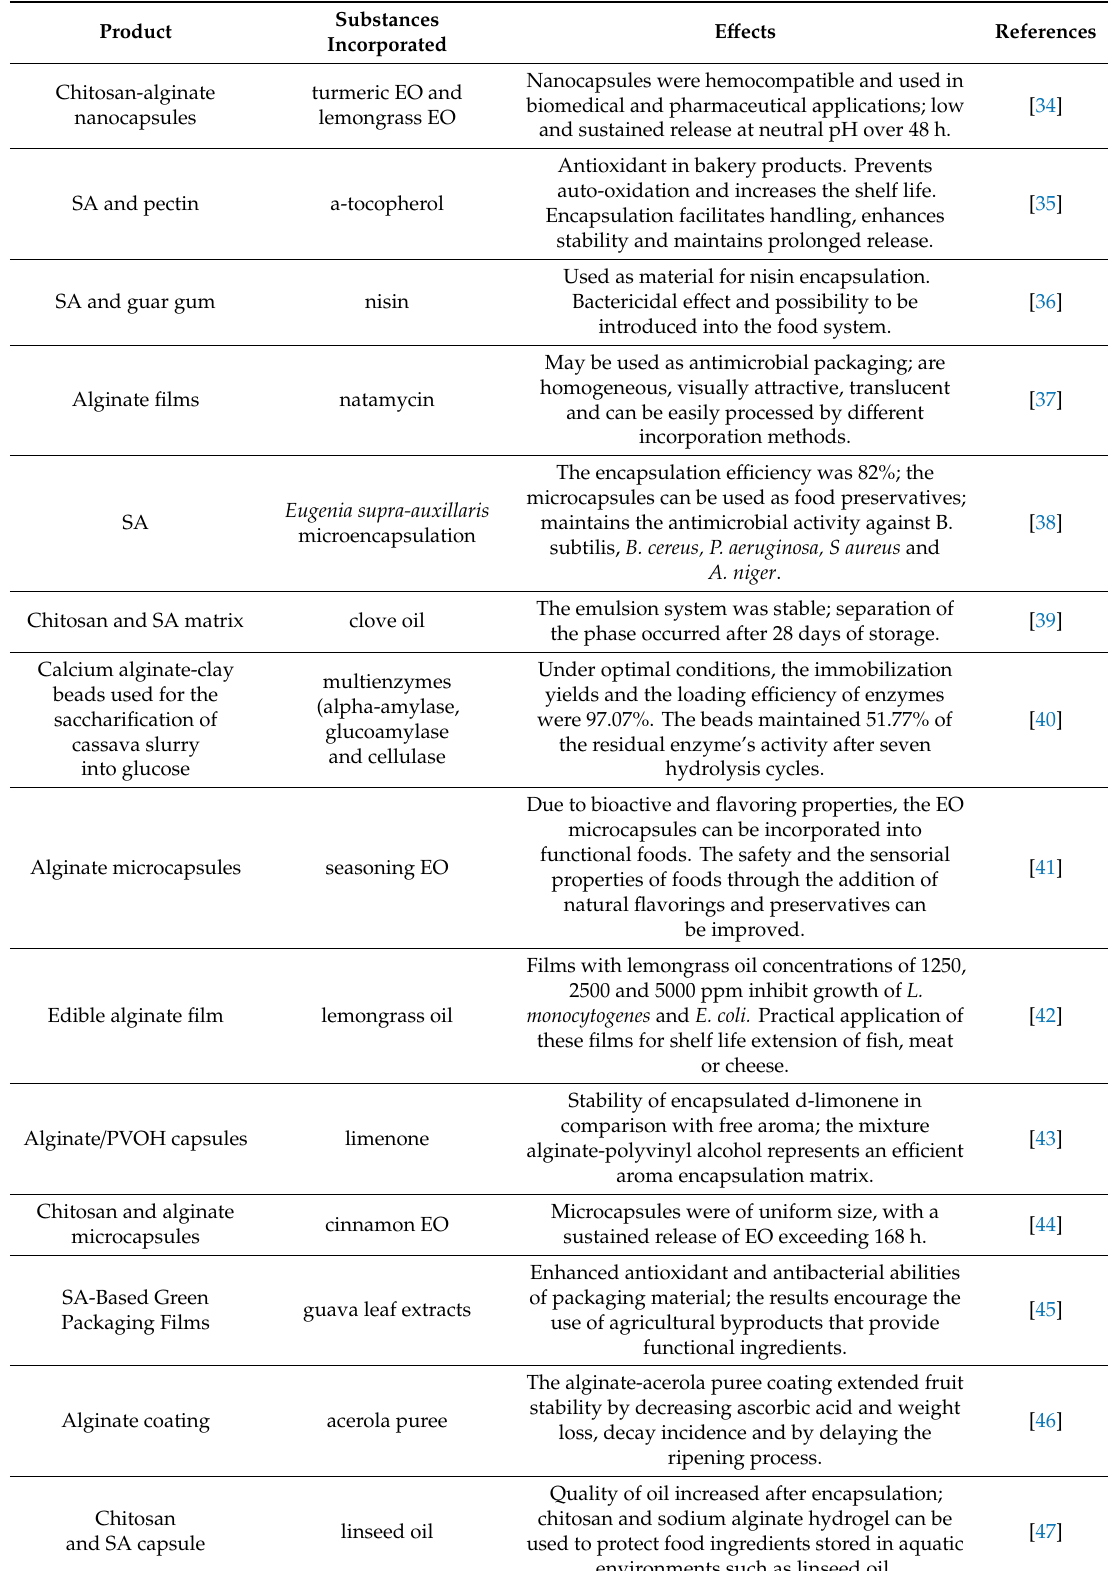
Table 1. Substances incorporated with